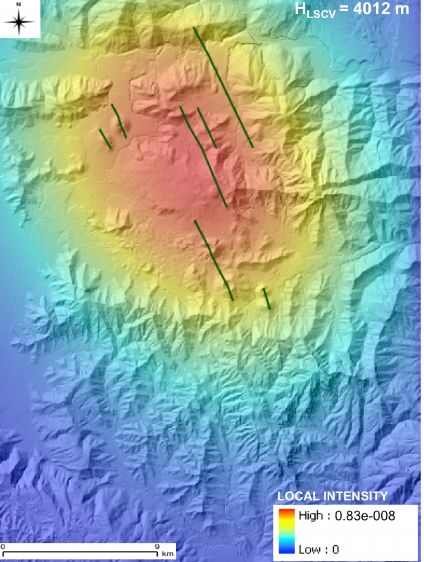
Fig. 10. PDFs calculated with the Gaussian kernel for the vent align- ments of La